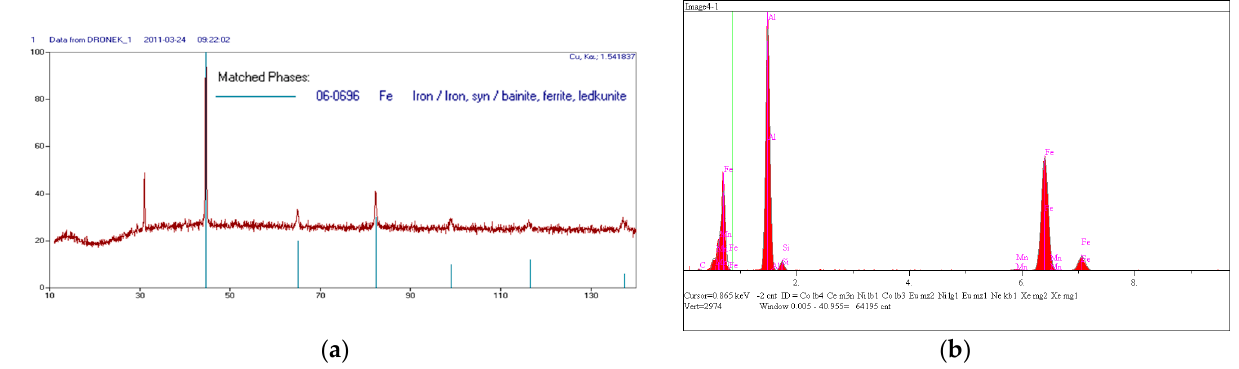
Figure 4. Decay powder diffractogram ( a ) and EDS X-ray microanalysis ( b ).